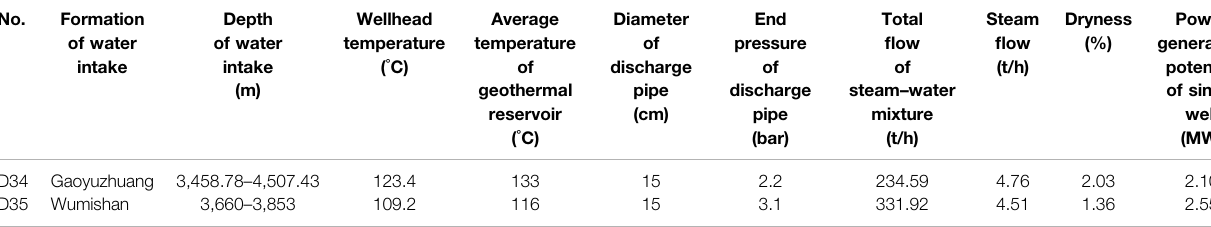
TABLE 1 | Parameters of geothermal well thermal reservoir capacity evaluation of D34 and D35.